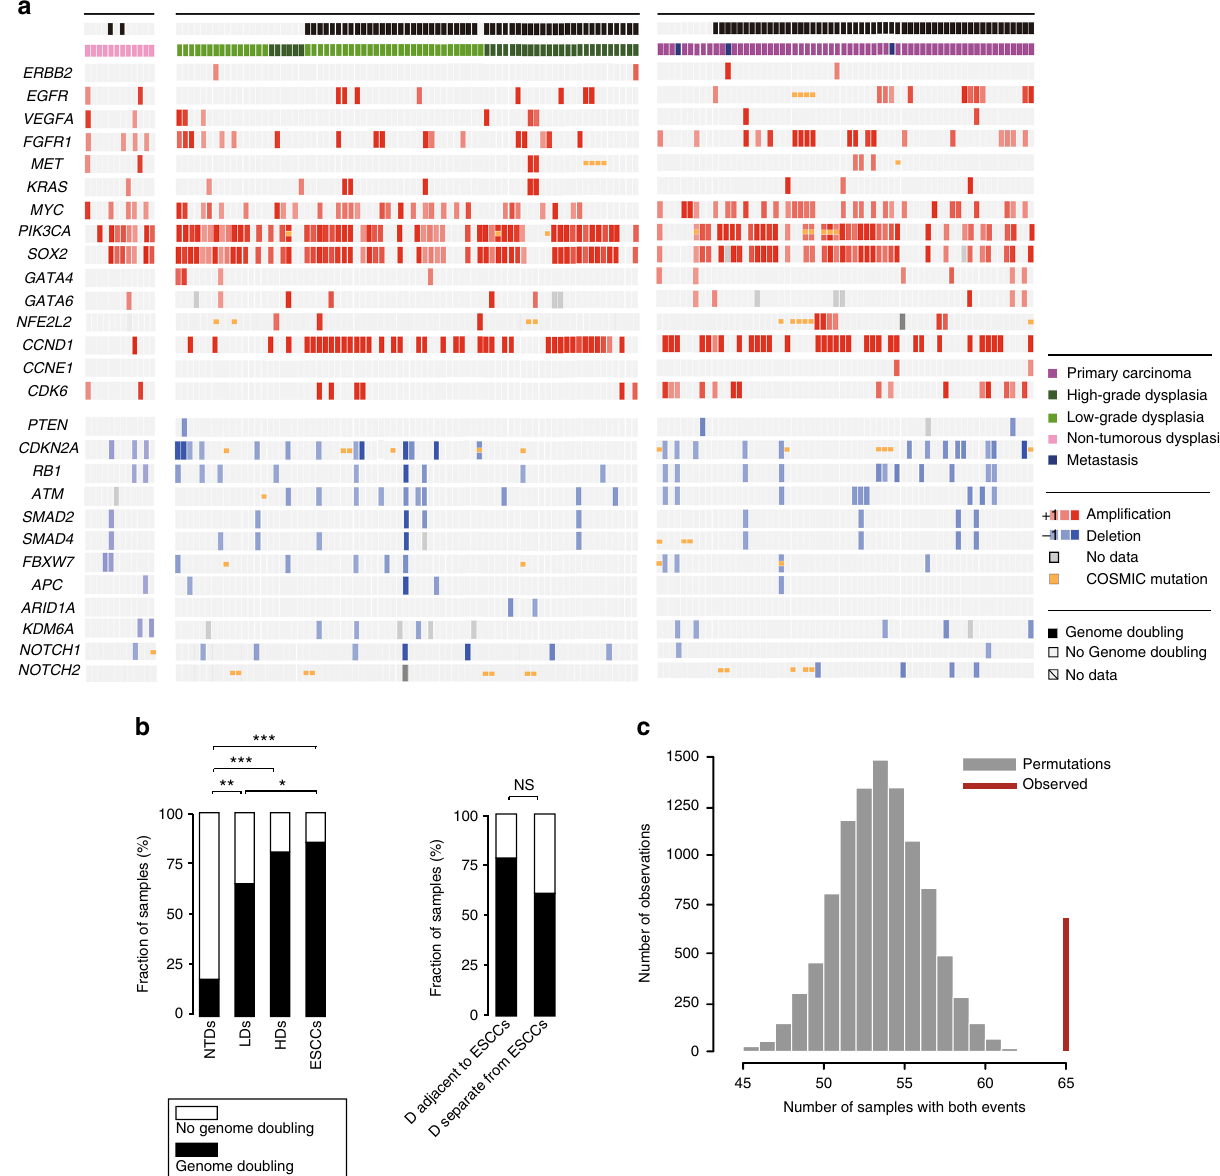
Fig. 5 Comparison of the key alterations in dysplasia and ESCCs. a Plots showing the ampli fi cation of oncogenes ( red ), deletion of tumor suppressor genes ( blue ), and COSMIC mutations ( orange ) in NTDs ( left ), LDs/HDs ( middle ), and ESCCs ( right ). The genome doubling status and histopathological types of the samples were marked on the top. The results in the sample NTD13 is not shown due to the non-available data in these focal genes. b Comparison of the frequency of genome-doubling status in NTDs, dysplasia samples and ESCCs. Dysplasia samples adjacent to and separate from ESCCs in the TD cohort were also compared. Fisher ’ s exact test, * P < 0.05, ** P < 0.01, *** P < 0.001, NS, not signi fi cant. c Permutation test of co-occurrence of genome doubling and CCND1 ampli fi cation. The gray bars represent numbers of samples with co-occurred genome doubling event and CCND1 ampli fi cation in permutations. The red line indicates the observed value in our data corresponding to an empirical P <